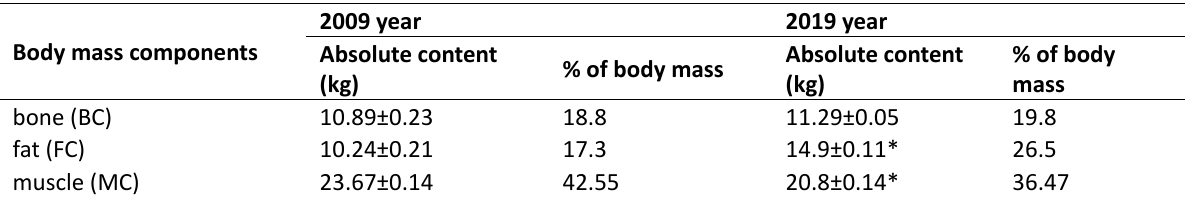
Table 2. The content of bone, fat and muscle components of females’ body mass surveyed in 2009 and 2019